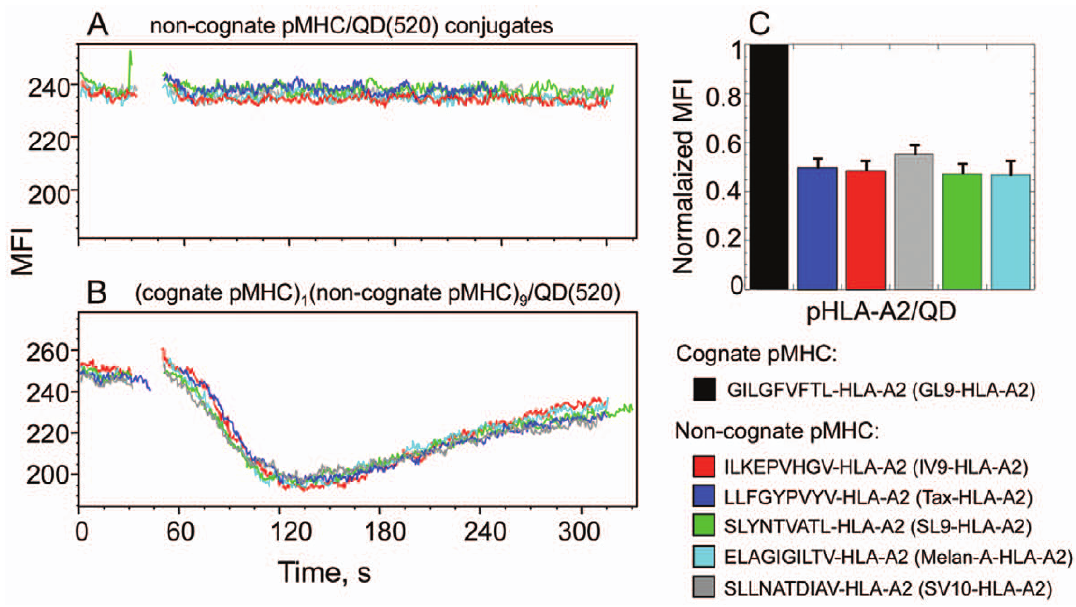
Figure 7. The dependence of cognate-noncognate pMHC-I cooperation on the nature of noncognate peptide. A, B. Ca 2 + mobilization in Fura Red-labeled CER43 CTL stimulated with QD(520) that display different noncognate pMHC-I proteins (10 per dot) ( A ) or 1 cognate and various noncognate pMHC (9 per dot) ( B ) is presented. C . Normalized values of MFI of CER43 cells interacting with either cognate or various noncognate pMHC-I are shown. The nature of cognate and noncognate pMHC-I ligands is designated (see Material and Methods for